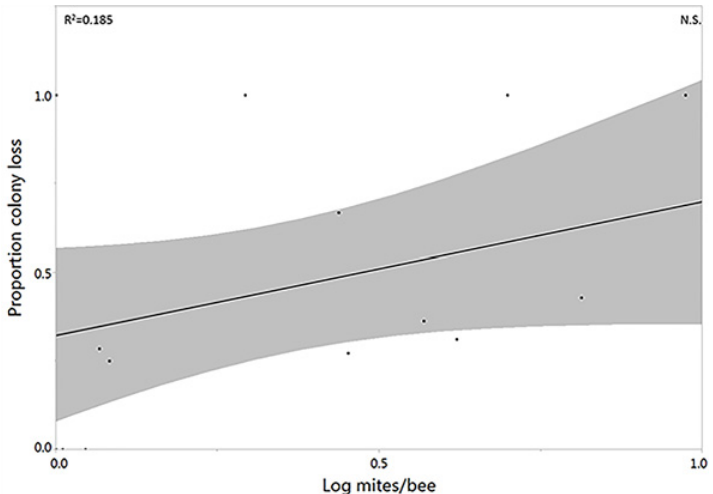
Fig 3. Relationship between apiary-average (from collected samples) Varroa mite infestation and apiary-average proportion hive losses. Shaded areas shows confidence of fit. N.S. denotes no significant